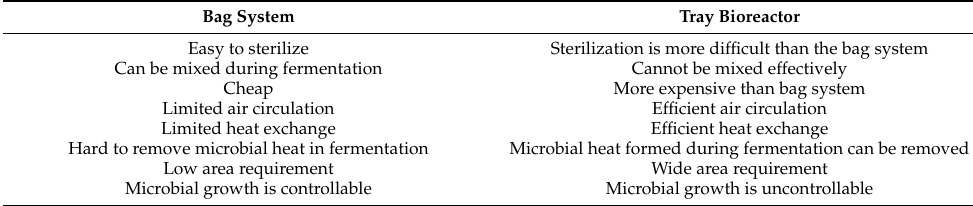
Table 1. Comparison of bag system and tray bioreactor. Bag System Tray